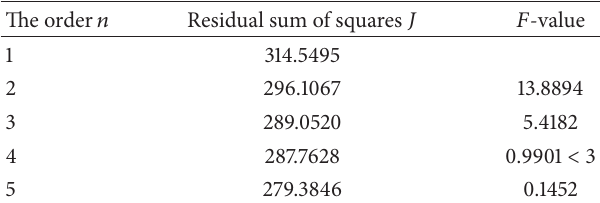
Table 3: Every class number and class